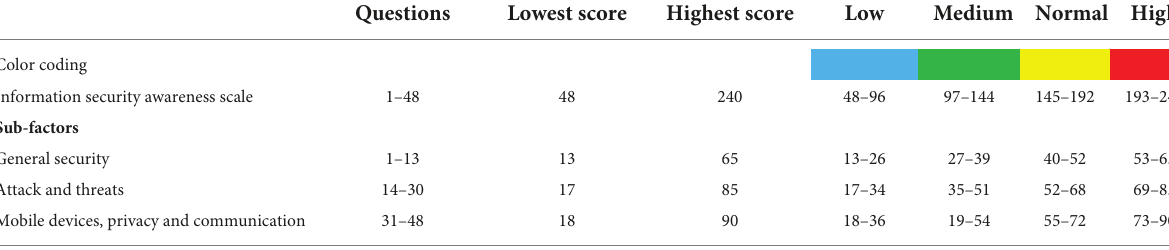
TABLE 1 Information security awareness scale and the lowest, highest scores and level ranges.